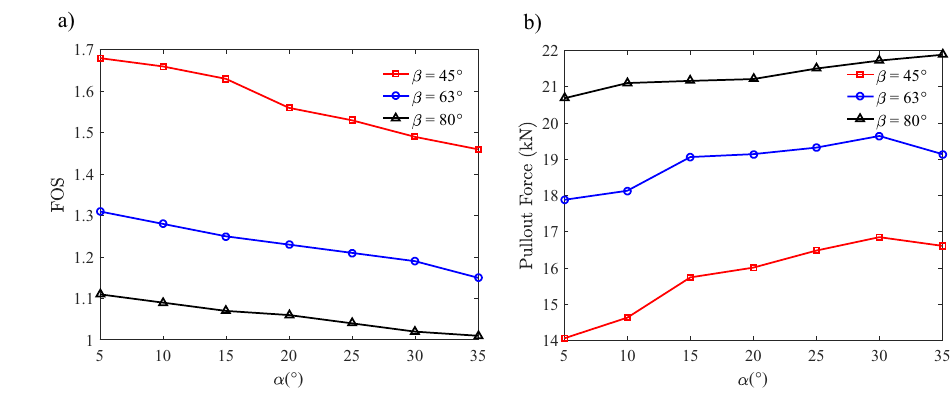
Fig. 11 The values of the factor of safety and the pull-out force at different angles of the